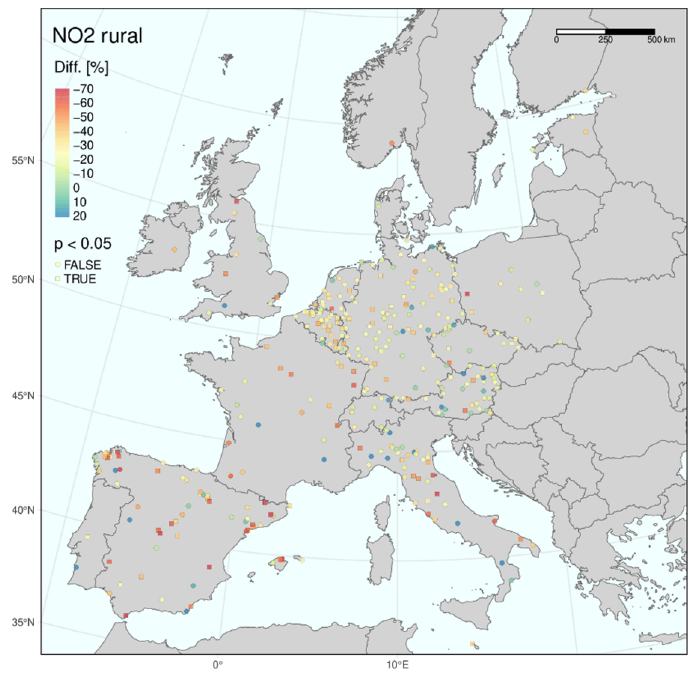
Figure 4. Same as Figure 3 for urban/suburban sites.